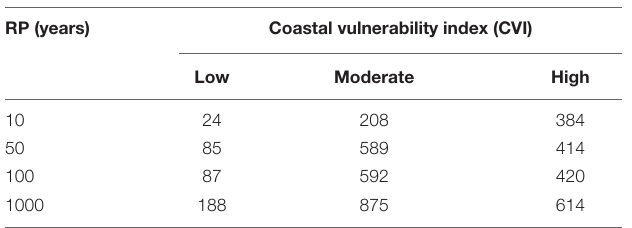
TABLE 2 | Number of landfills located in the coastal floodplain associated with different return periods and SLR projections. SLR scenario (m)